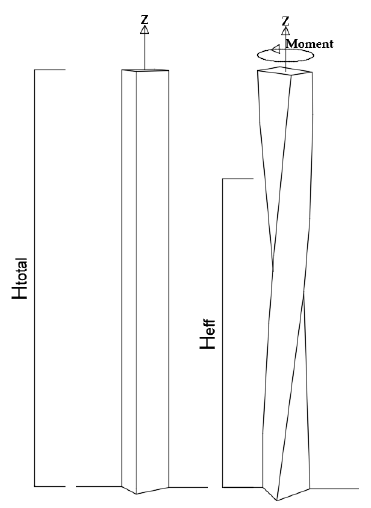
Figure 2. Development of torsional stiffness due to the shear mechanism. The elastic torsional radius due to shear mechanism ( b s ) can be determined from the square root of the sum of the ratio of torsional stiffness ( K θ ) to translational stiffness ( K ) of each wall or column in the building as shown in Equation (1). In Equation (1), ‘b y,S ’ is the torsional stiffness radius due to the shear mechanism developed for y-direction of ground motion, and K x , i is the translational stiffness of element ‘ i ’ about the x-axis.